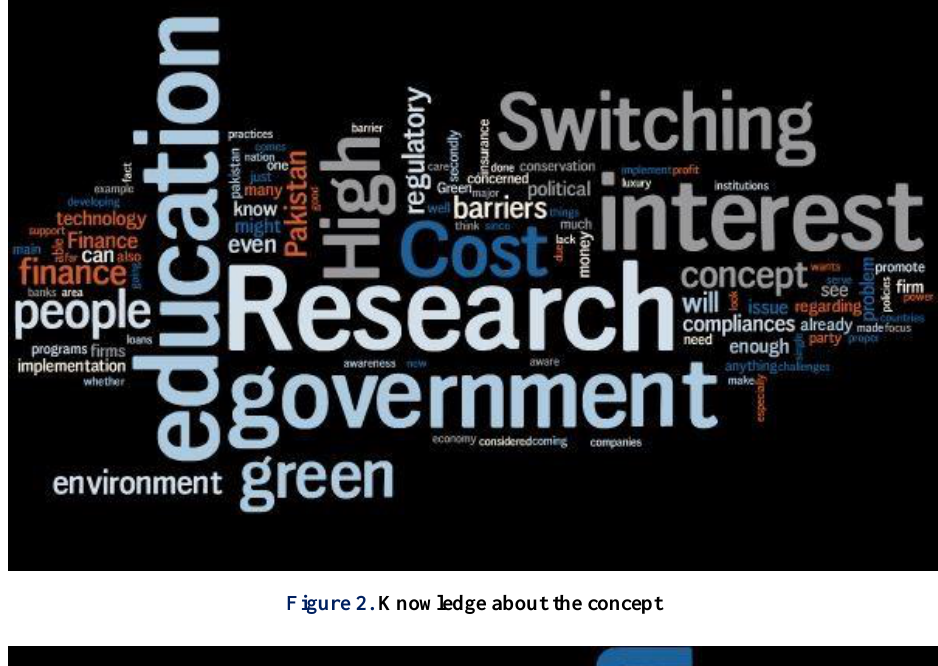
Figure 2. Knowledge about the concept